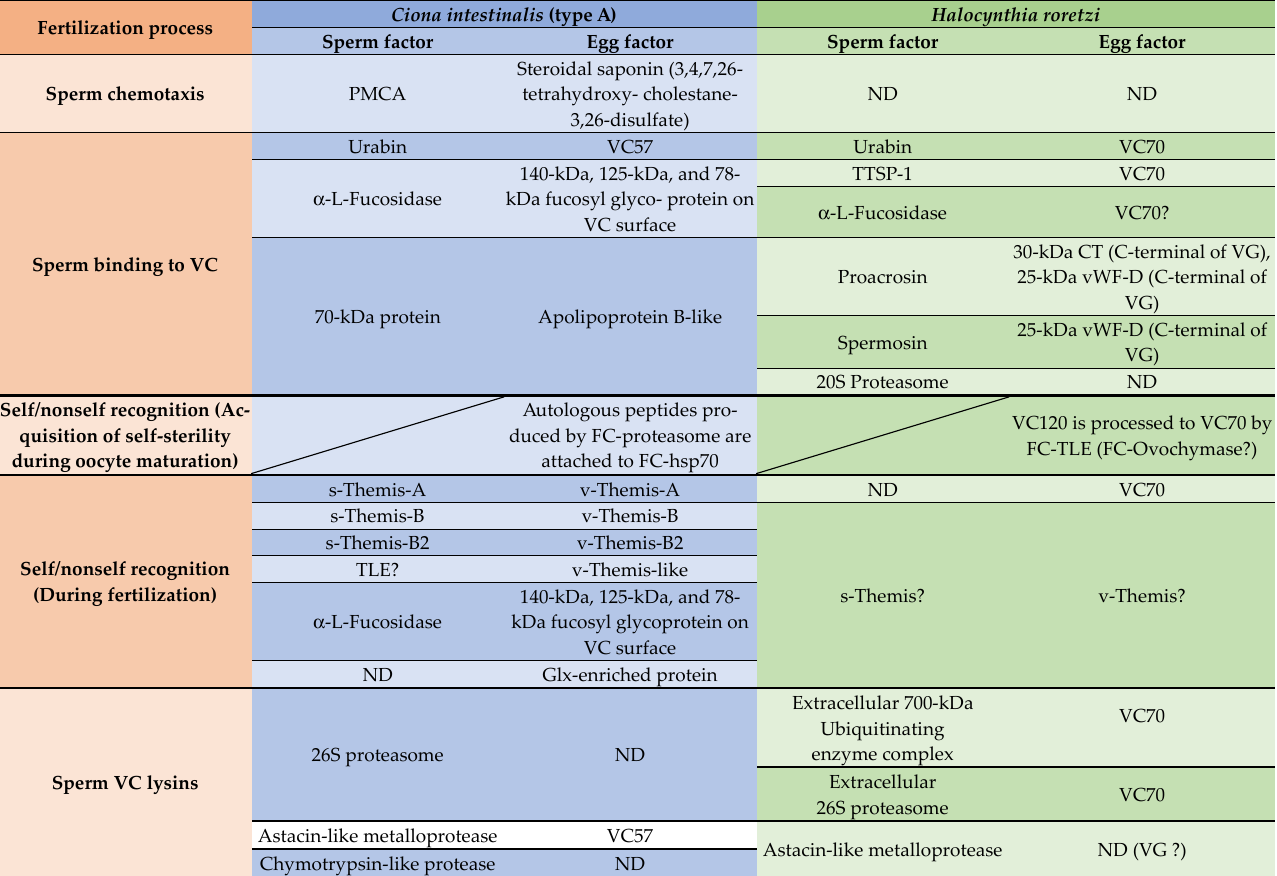
Table 1. Candidate molecules involved in gamete interactions and lysins in C . intestinalis and H . roretzi .